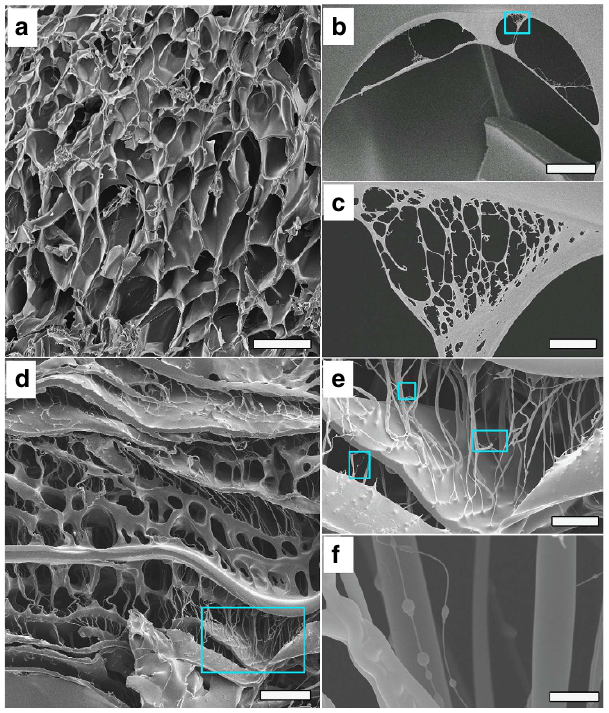
Figure 5 | Morphology and structure of PAM/CNS xerogels. ( a ) Scanning electron microscope (SEM) image of C40 (NC gel with 40p.p.m. CNS concentration) xerogel. Scale bar, 500 m m. ( b ) Zoomed SEM image of the box region in a . Scale bar, 30 m m. ( c ) Zoomed SEM image of the box region in b . Scale bar, 2 m m. ( d ) SEM image of C200 (NC gel with 200p.p.m. CNS concentration) xerogel. Scale bar, 100 m m. ( e ) Zoomed SEM image of the box region in d . Scale bar, 30 m m. ( f ) Zoomed SEM image in the region of the top one of the three boxes in e . Scale bar, 2 m